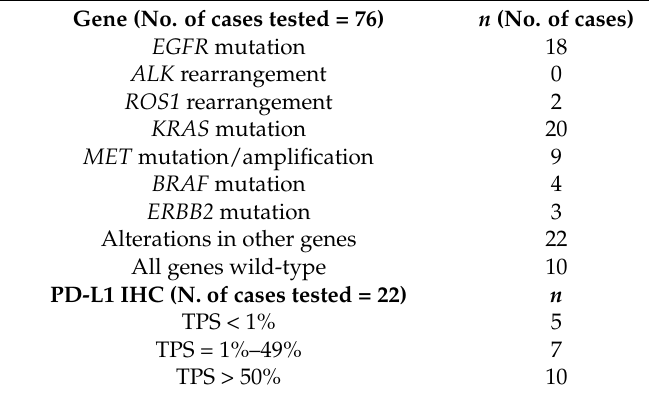
Table 2. Frequencies of genomic alterations and PD-L1 expression detected in NSCLCs from the octogenarian patients of the study. Gene (No. of cases tested = 76) n (No. of cases) EGFR